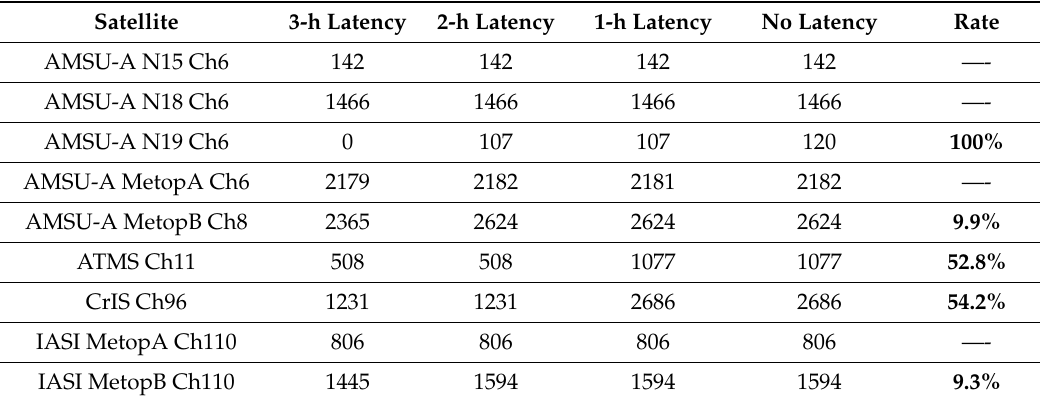
Table 2. The data coverage increasing rate at 1800 UTC 23 June, 2018.